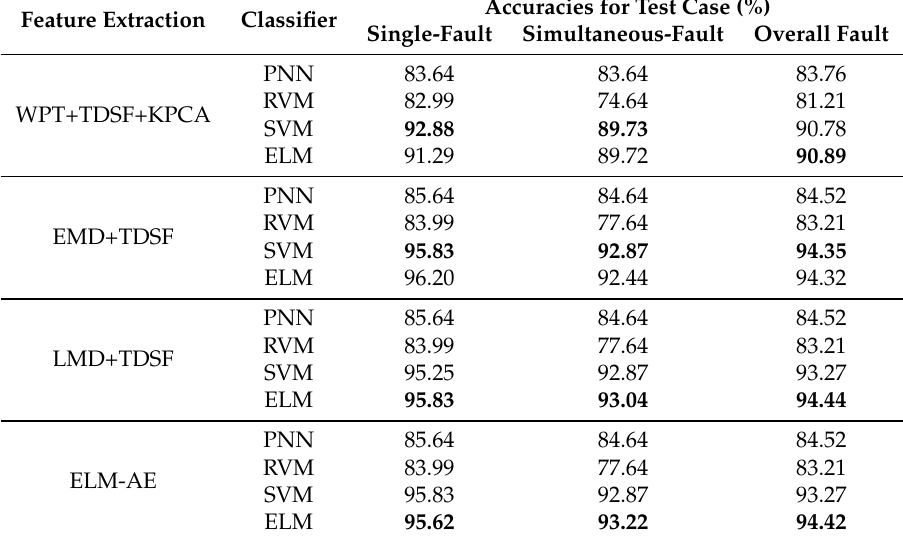
Table 5. Evaluation of different combinations of methods using the optimal model parameters. Wavelet packet transform: WPT; time-domain statistical features: TDSF; kernel principal component analysis: KPCA; empirical mode decomposition: